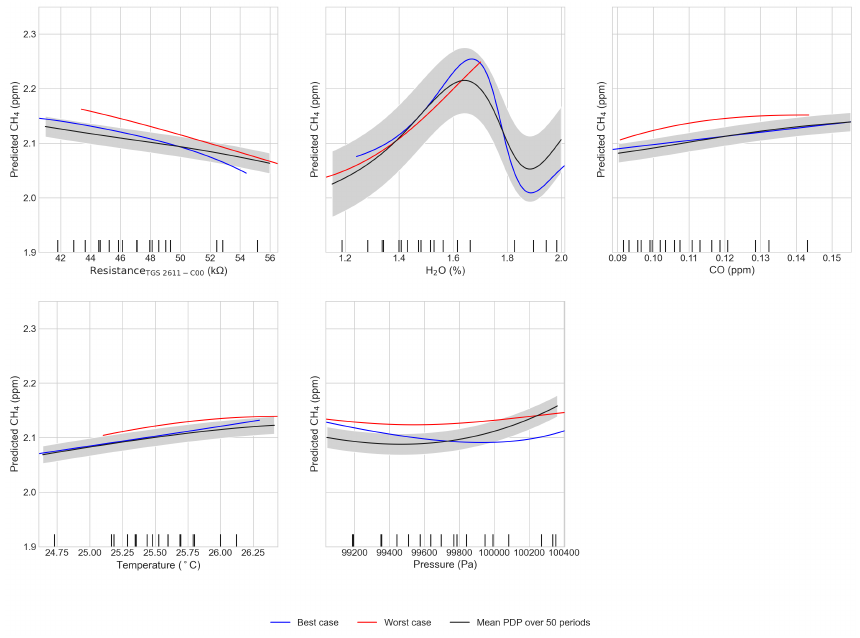
Figure 10. Partial dependence plot for the best (blue) and worst (red) case and mean Partial de- pendence plot computed over the 50 periods (black), the shaded gray area is the uncertainty (1œ) for the 50 periods. The inputs of the model were the Figaro 2611-C00 resistance, water vapor mole fraction, CO, air temperature and pressure. Ticks on the x axes of the figures are the deciles of the input